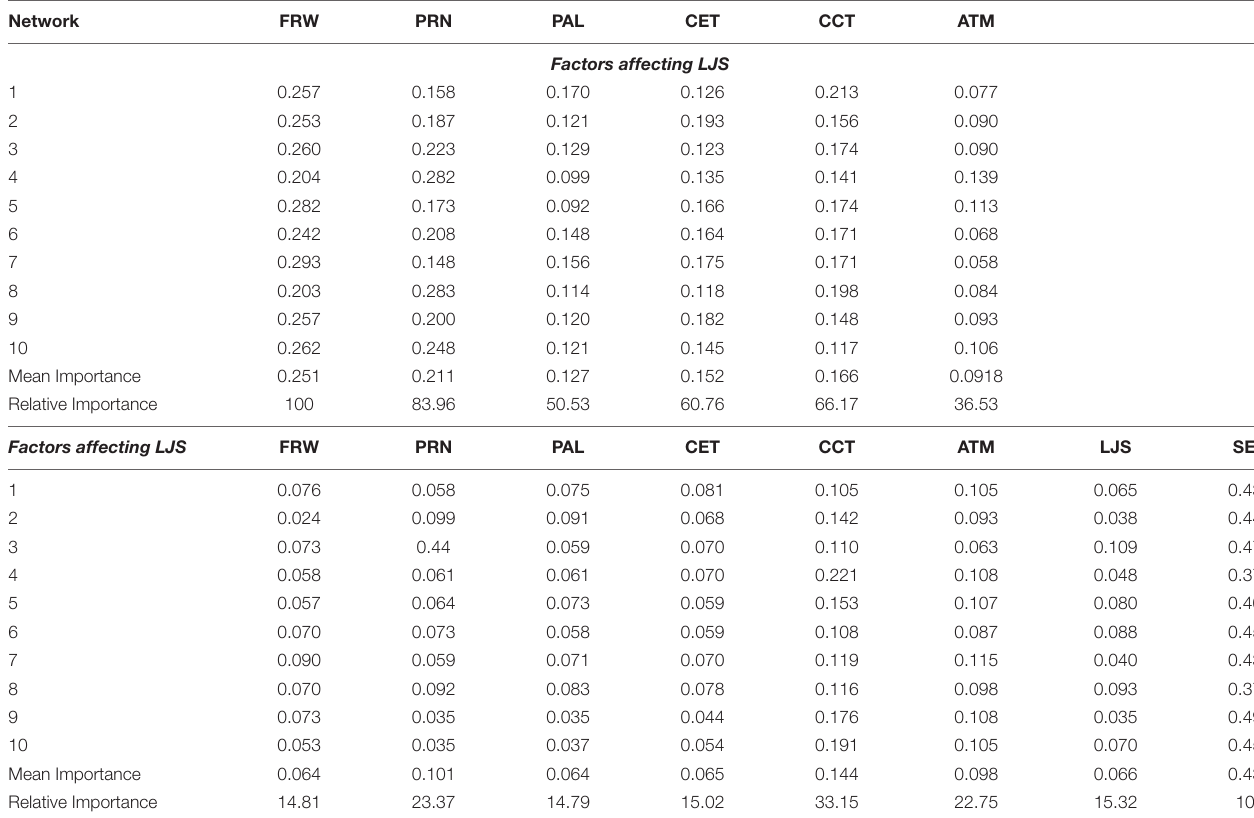
TABLE 8 | Sensitivity